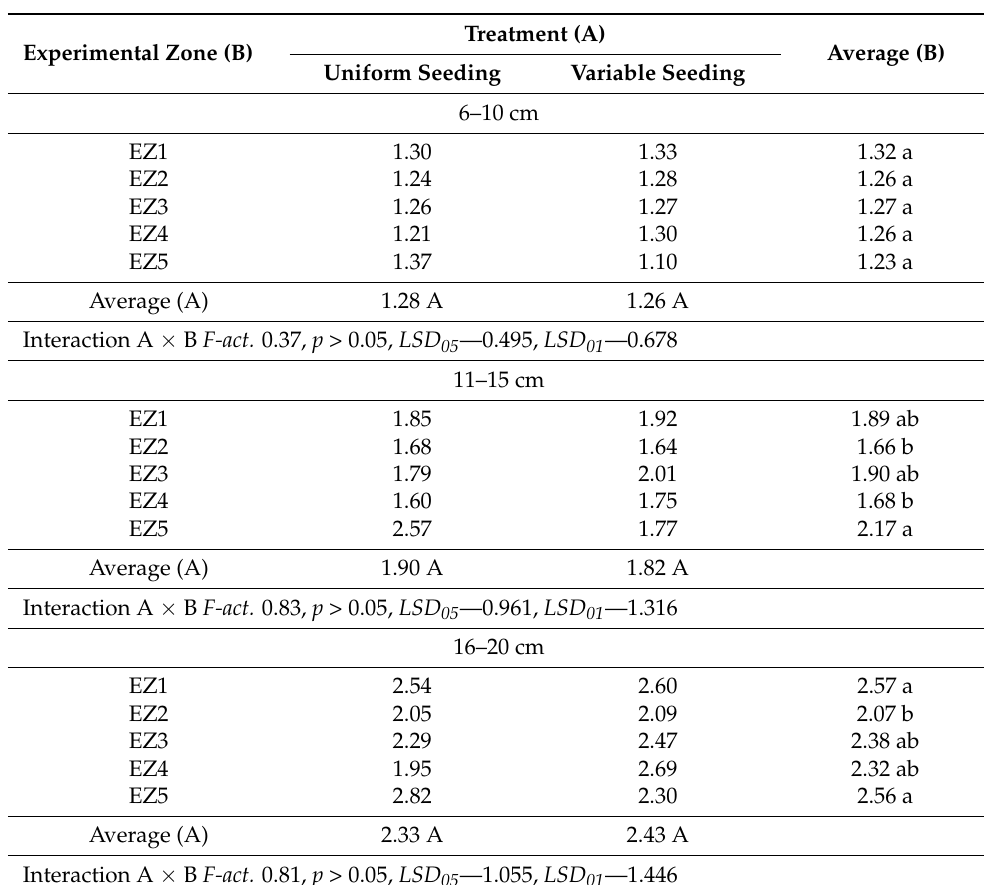
Table 3. Cont. Experimental Zone (B)